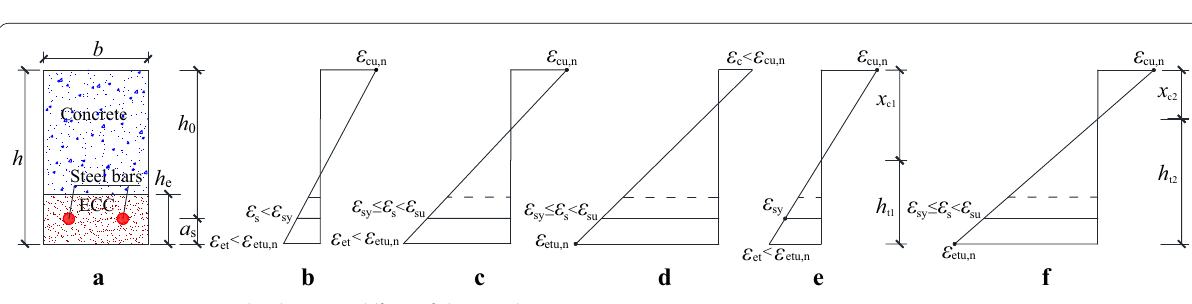
Fig. 12 Cross-section strain distribution at different failure